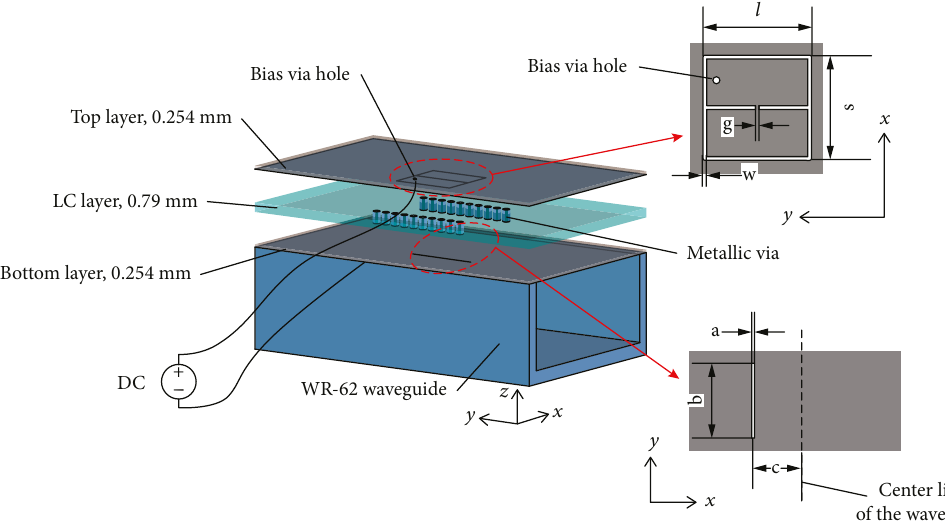
Figure 1: Schematic diagram of the proposed antenna array